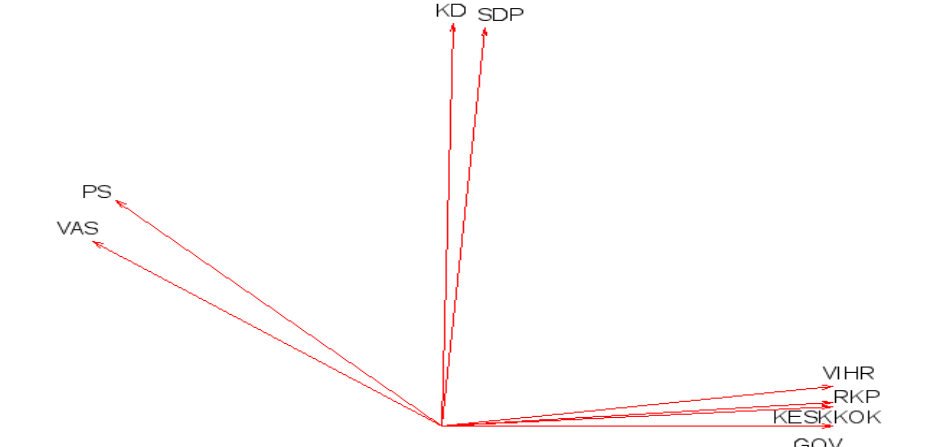
Figure 2e. Government and opposition voting during the Vanhanen II and Kiviniemi governments (2007-2010)